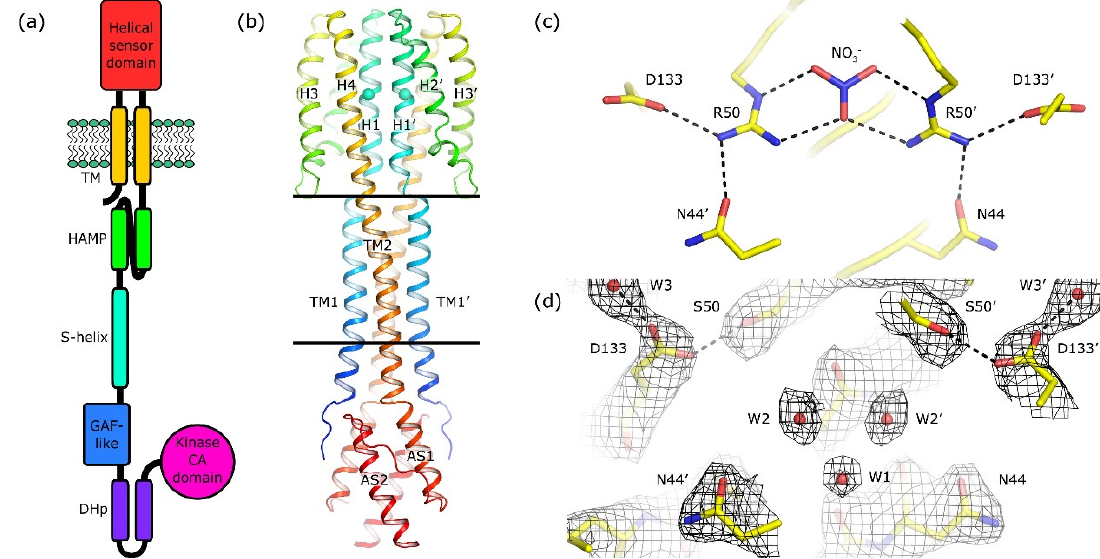
Figure 1. Architecture of NarQ and structure of the R50S mutant. Elements belonging to the second protomer in the dimer are marked with primes. ( a ) Architecture of NarQ (adapted from [9]). Note that the functional protein is homodimeric. Approximate domain boundaries, according to InterPro [17], are: TM1, residues 14–34; sensor, 39–146; TM2, 147–167; HAMP, 172–227; S-helix, 228–246; GAF-like, 247–360; DHp, 361–425; CA, 424–560. ( b ) Overall structure of the sensor-TM-HAMP fragment of the R50S mutant. Position of Ser50 is highlighted with spheres. The backbone structure is identical to that of the WT protein (Figure S1a). ( c ) Structure of the ligand-binding site in the WT protein. ( d ) Structure of the ligand-binding pocket in the R50S mutant. Asp133 is reoriented towards Ser50. 2F o − F c electron density maps are contoured at the level of 1.2 × r.m.s. Putative water molecules are shown as red spheres.